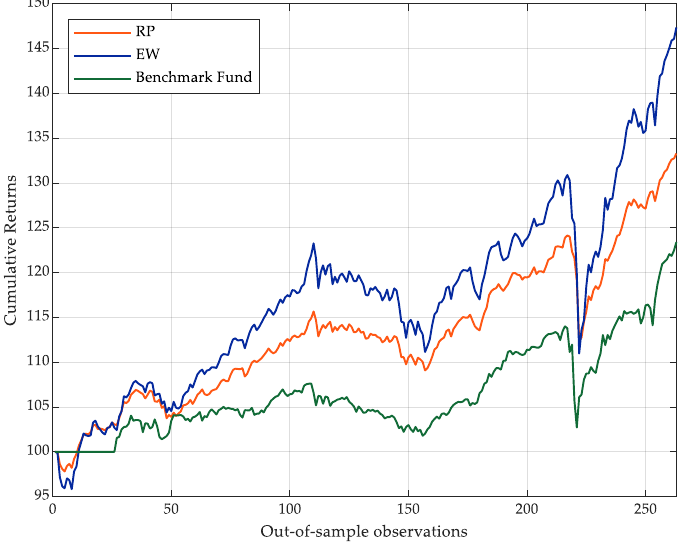
Figure 3. Conventional Portfolio returns (in-sample w = 244; out-of-sample w = 262). Note: to improve table clarity, returns were normalised on a scale of 100.